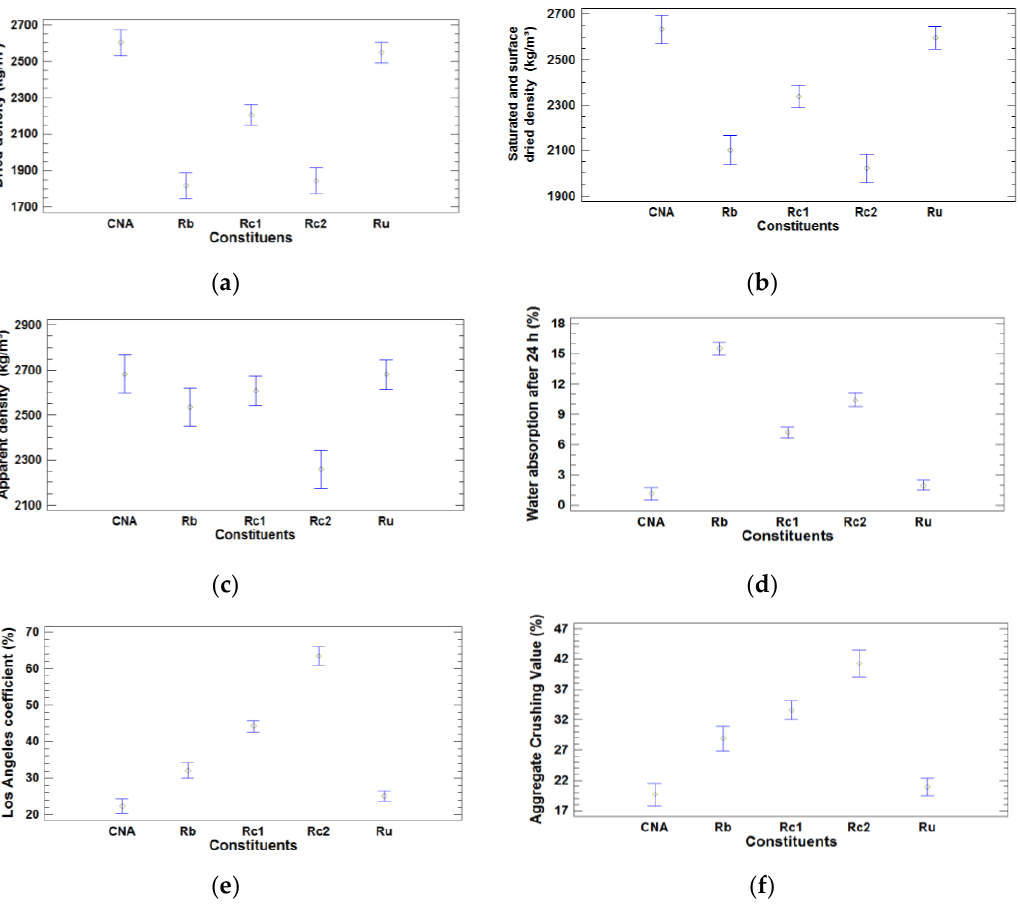
Figure 4. Means and 95.0 percent LSD intervals of each physical – mechanical property studied: ( a ) oven-dried particle density, d rd ; ( b ) saturated and surface dried particle density, d SSD ; ( c ), Apparent particle density, d a ; ( d ) water absorption after 24 h, WA; ( e ), Los Angeles coefficient, LA, and ( f ) Aggregate Crushing Value, ACV.